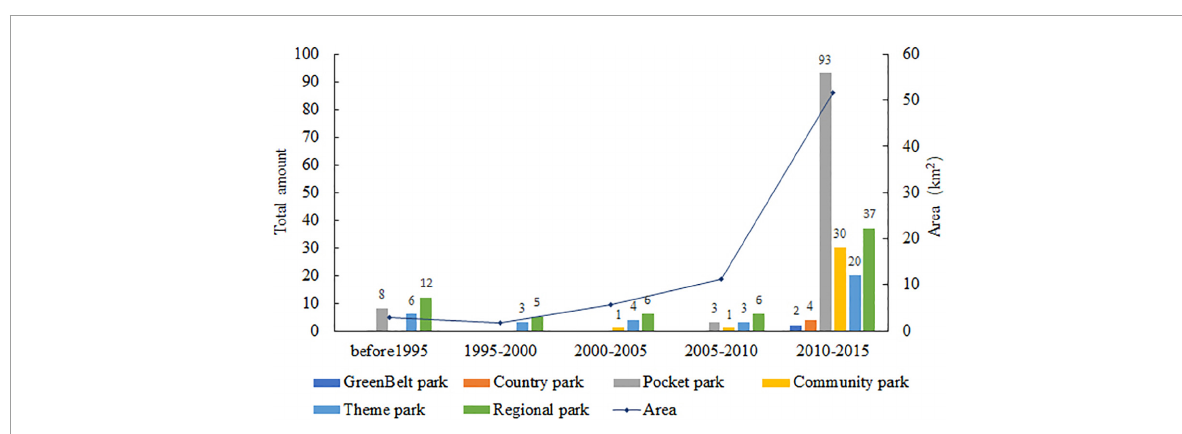
FIGURE9 Amount and area of various types of parks in different periods.